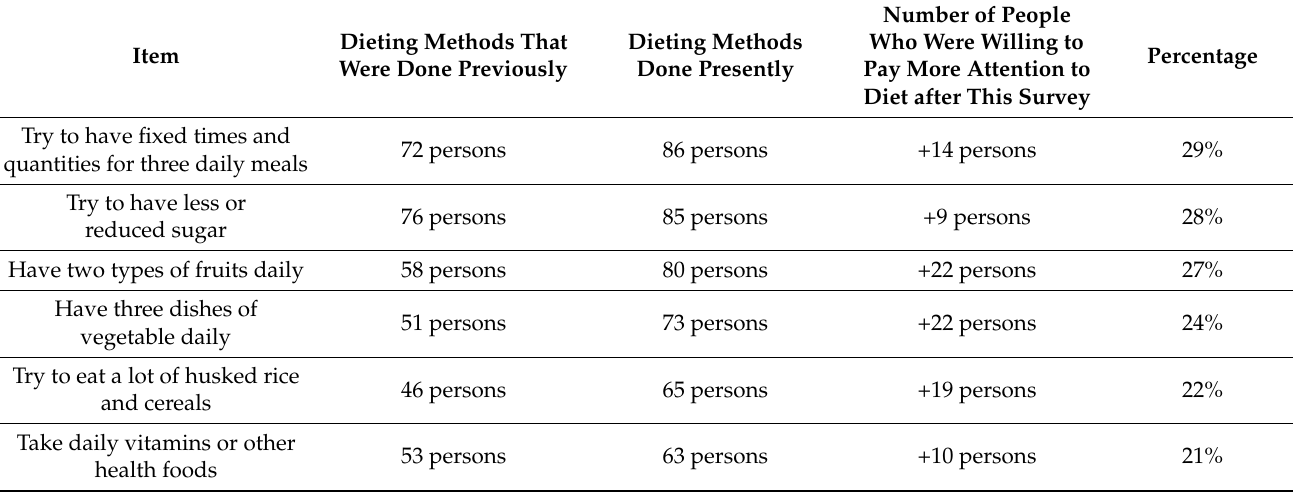
Table 4. Comparison of present dieting